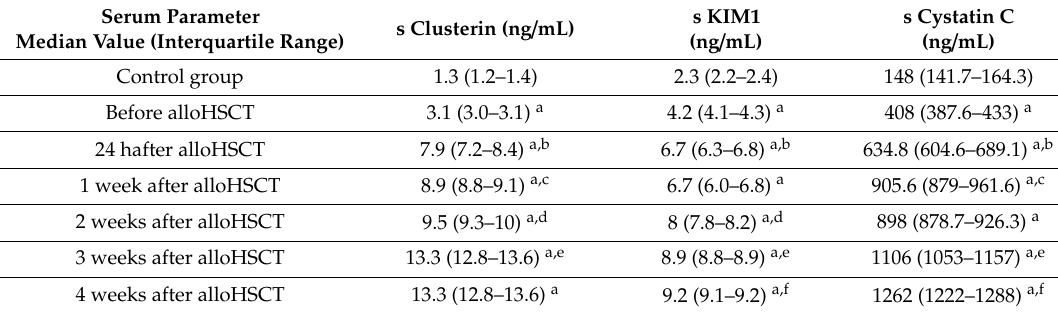
Table 2. Serum parameter values in examined groups.